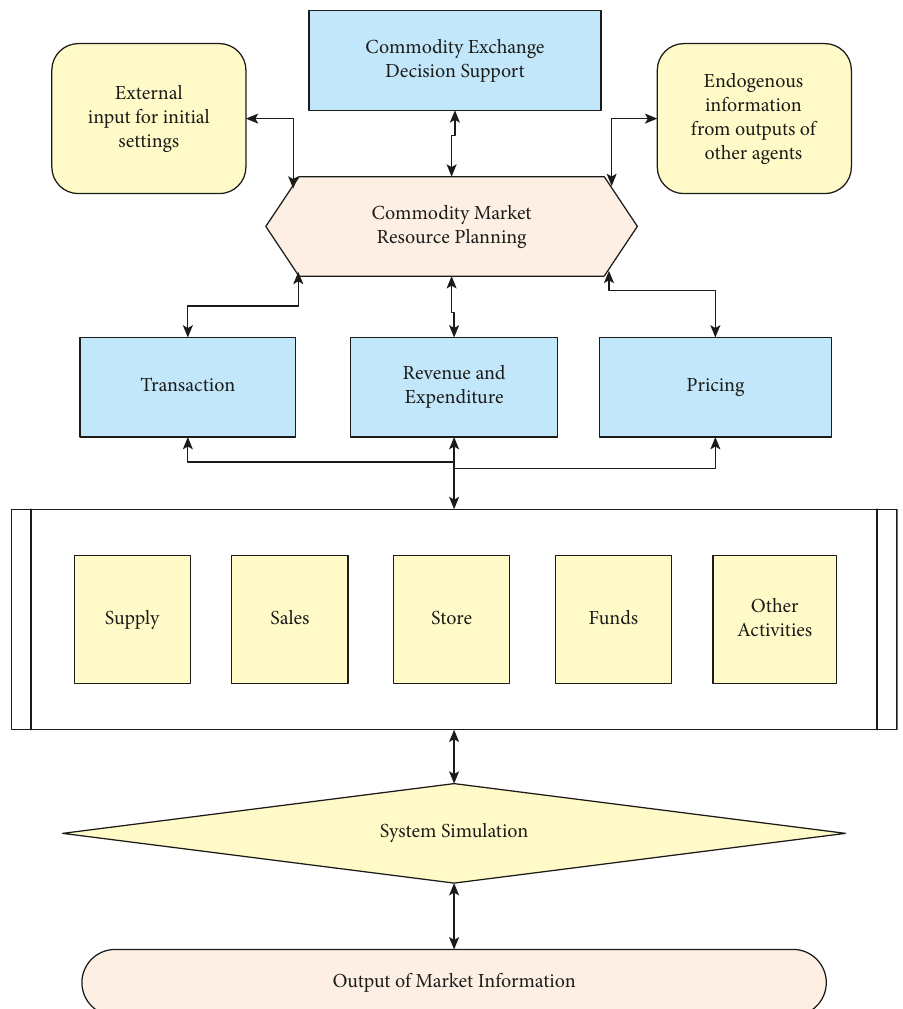
Figure 4: Overview of the process and structure of market system (source: Guangzhou Milestone Software Co., Ltd.,